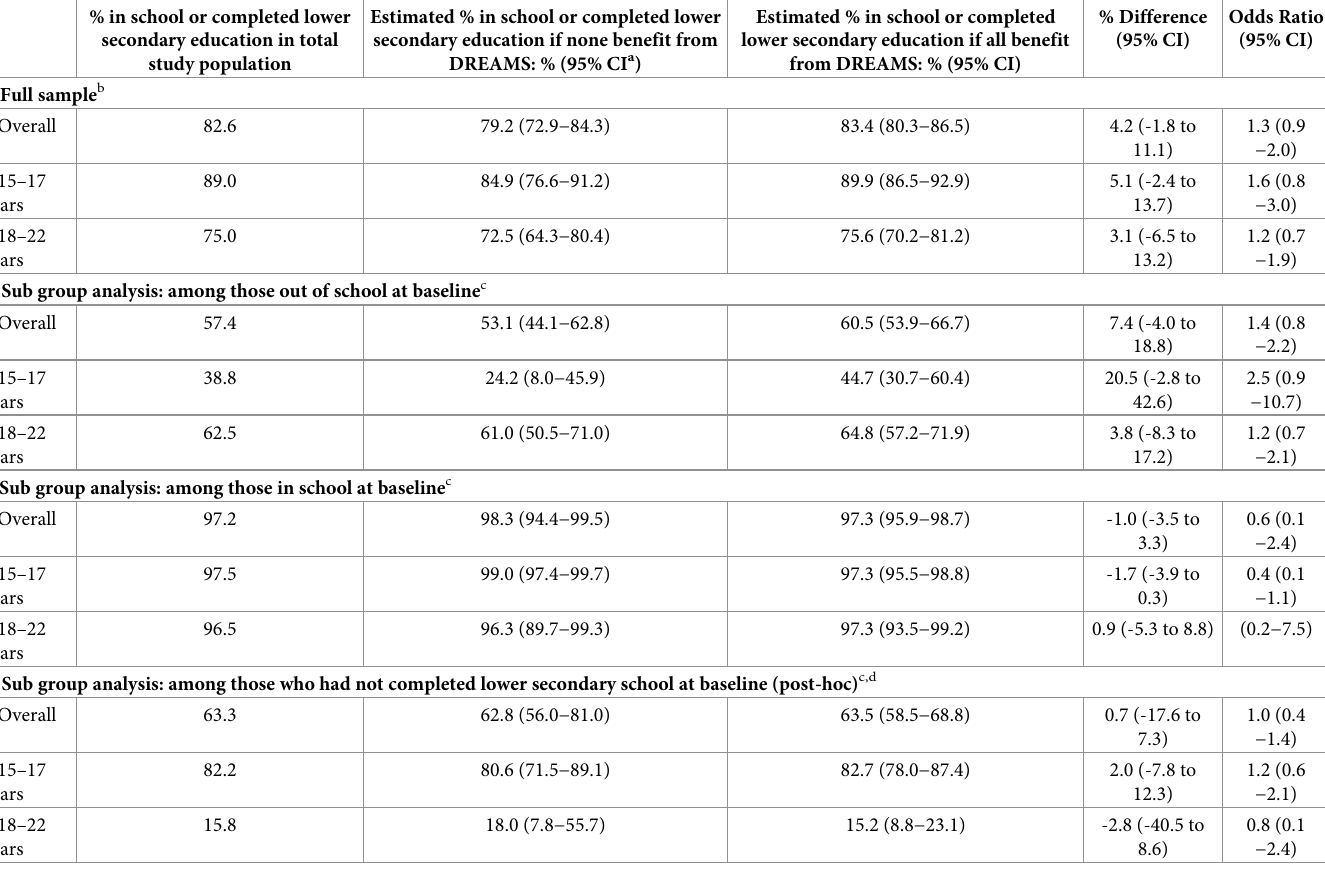
Table 5. (a, b, c, d) Estimated causal effect of DREAMS on educational attainment, from regression analysis with adjustment for the ‘propensity to be a DREAMS beneficiary’. % in school or completed lower secondary education in